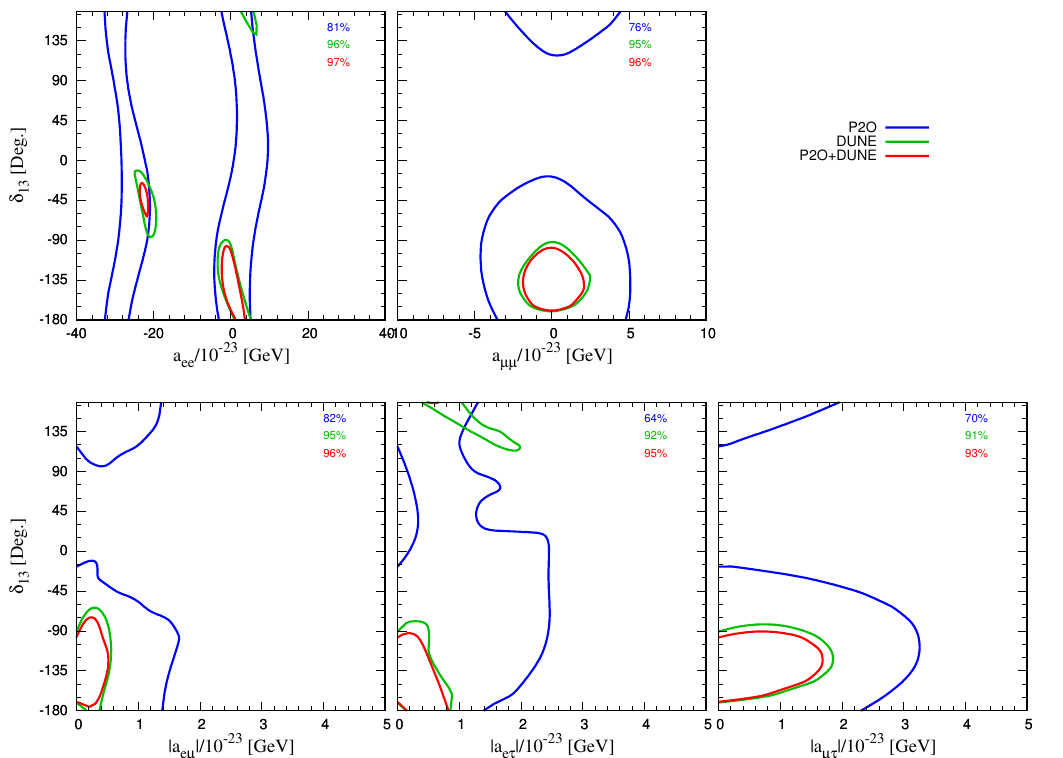
Figure 7 . Exclusion regions at 95% C.L., showing the correlations of the LIV parameters with the CP phase δ 13 for P2O (blue contours), DUNE (green) and P2O+DUNE (red contours). Similar to figure 5, the triplet of numbers ( % ) in each panel indicates the area of parameter space excluded at 95% C.L., expressed as a percentage of the total area of the parameter space